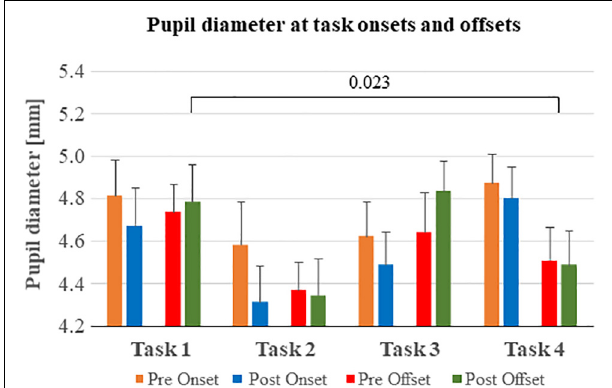
FIGURE 4 | Pupil diameter before and after task onsets and offsets. The pupil diameter reached a minimum in all analysis windows (Pre onset, Post onset etc.) during task 2. In tasks 1 and 3, the participant encountered an immediate threat, in most cases within the first 5 s of scenario. During tasks 2 and 4 the threat appeared delayed more than 5 s into the scenario.